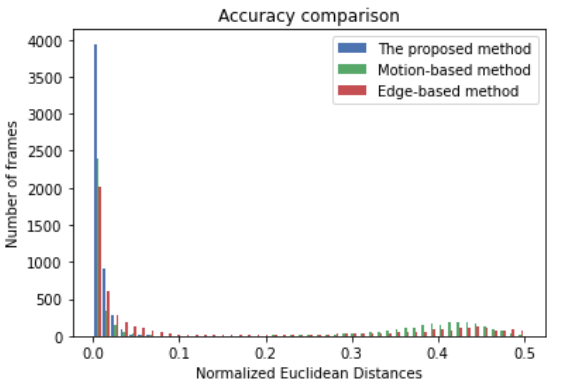
Figure 6. Distribution of normalized error of the proposed (blue), existing motion-based (green), and edge-based (red) R-VP detection methods. Table 1. Performance comparisons of the proposed, the motion-based [33] and the edge-based [29] methods in terms of the average distance between the detected and ground truth R-VPs, its standard deviation, and processing time.